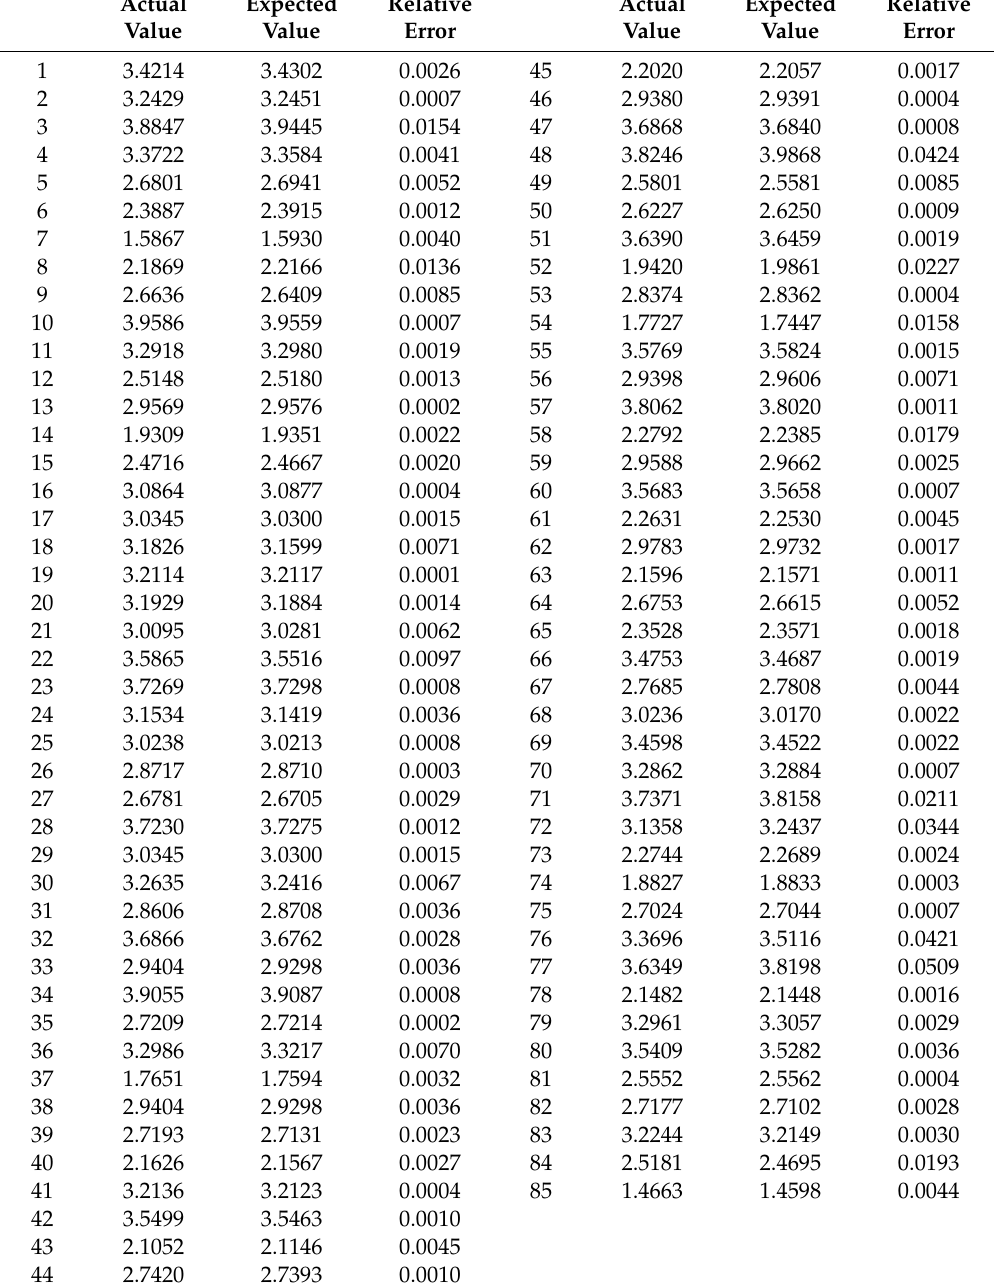
Table A1. Network output results of Hongxia